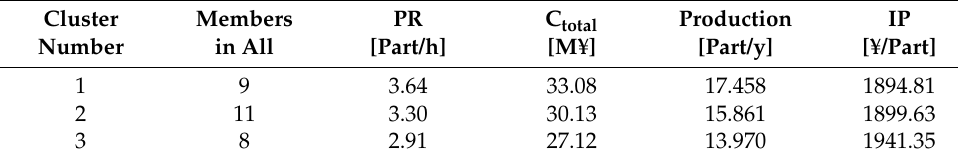
Table A11. Cluster analysis of the original approach [4] (Case